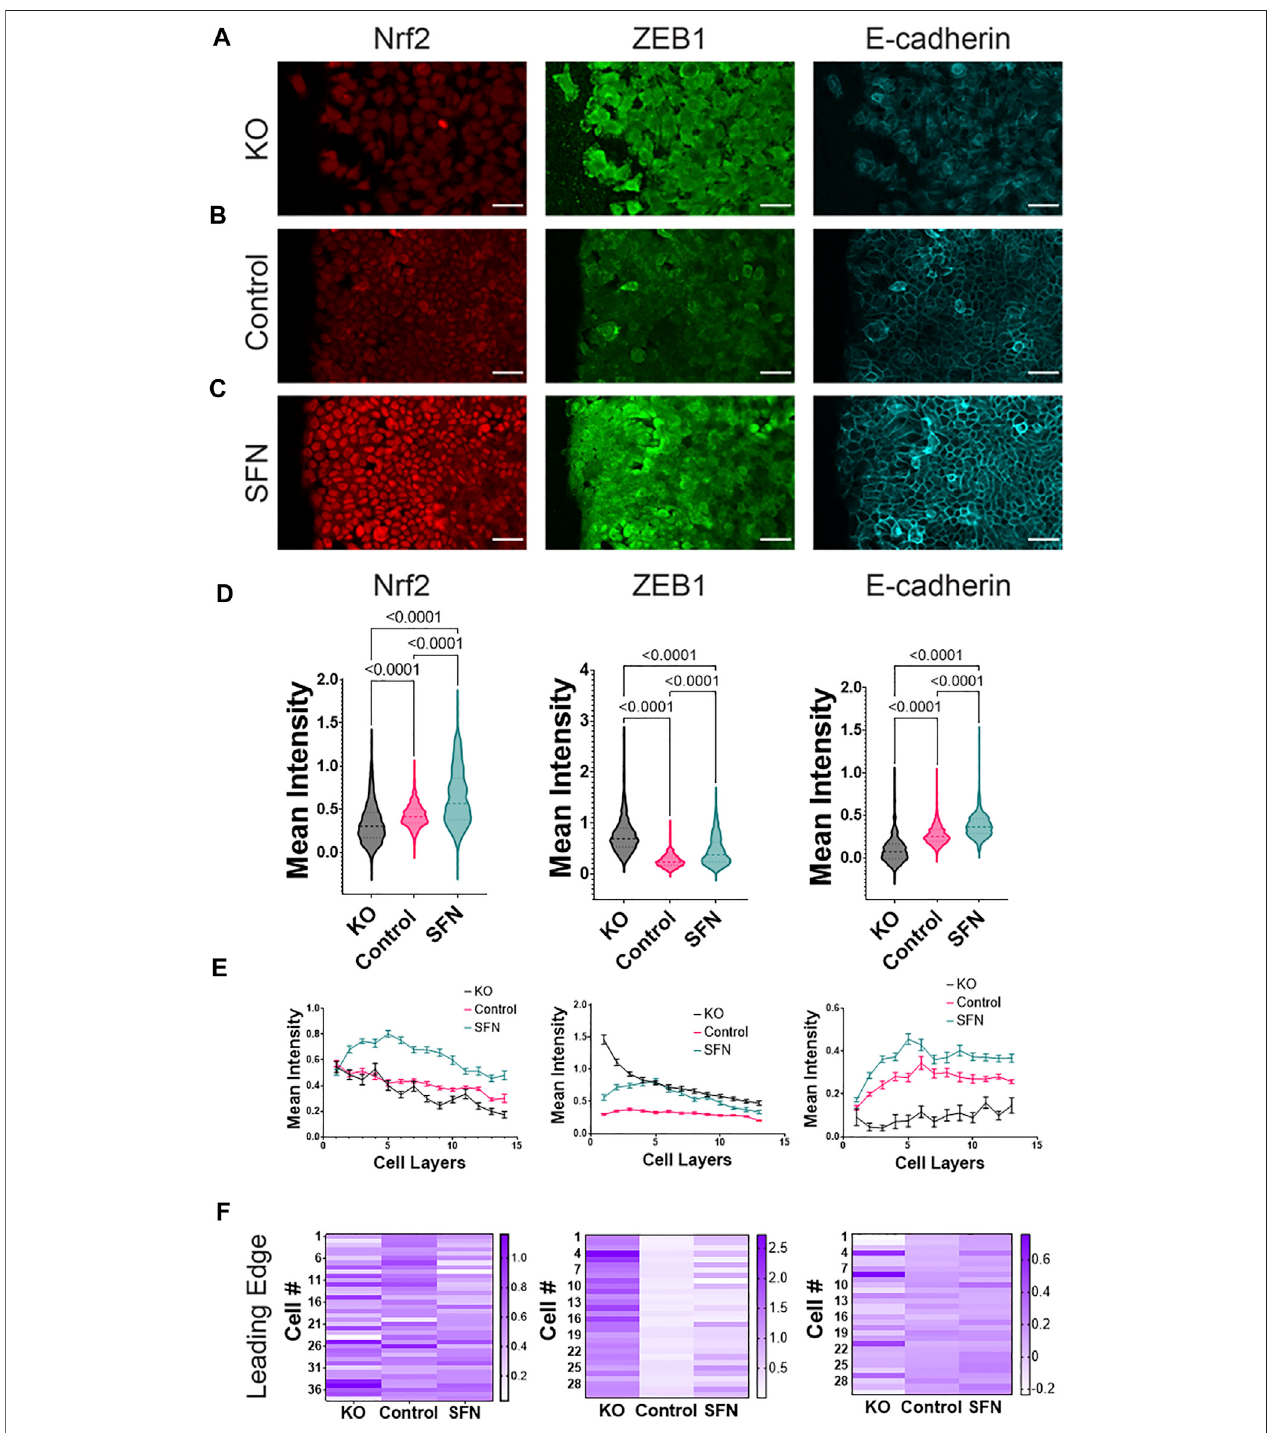
FIGURE 1 | Nrf2 modulates EMT near the leading edge during collective migration. (A – C) Immunocytochemistry of RT4 bladder cancer cells measuring Nrf2 (left column),ZEB1(centercolumn),andE-cadherin(rightcolumn)proteinlevelsinacellmigrationassayfor (A) CRISPR/Cas9NFE2L2-KOPoolRT4cells(KO), (B) RT4cells (Control), and (C) sulforaphane treated (7.5 μ M, 24 h) RT4 cells (SFN), respectively. Scale bars, 50 μ m. (D – F) Quanti fi cation of immunocytochemistry data. (D) Average intensity of each cell in the whole monolayer. One-way ANOVA with post-hoc Tukey ’ s test was used to compare across groups (NRF2: KO n = 598 cells, Control n = 503 cells, and SFN n = 564 cells. ZEB1: KO n = 385 cells, Control n = 1267 cells, and SFN n = 1166 cells. E-cadherin: KO n = 385 cells, Control n = 1268 cells, and SFN n = 1166 cells). (E) Intensity distribution in the migrating monolayer measured as number of cell layers (position from the leading edge). Data represent mean ± S.E.M. (F) Heatmap of representative cells at the leading edge for Nrf2, E-cadherin, and ZEB1, respectively. Each cell at the leading edge is indicated by “ Cell # ” where cell #1 refers to the fi rst measured cell from top to bottom. Results are from six experiments performed across different days.